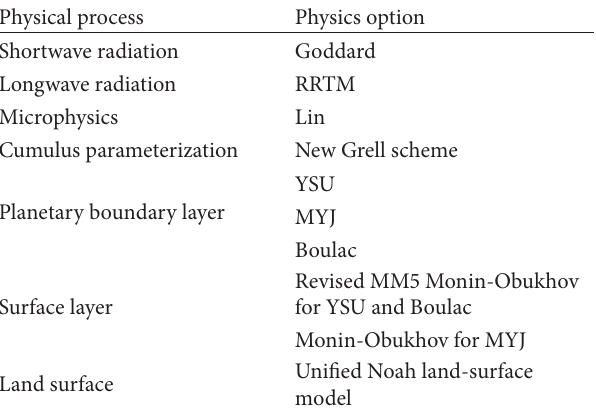
Table 1: Main physical schemes used in